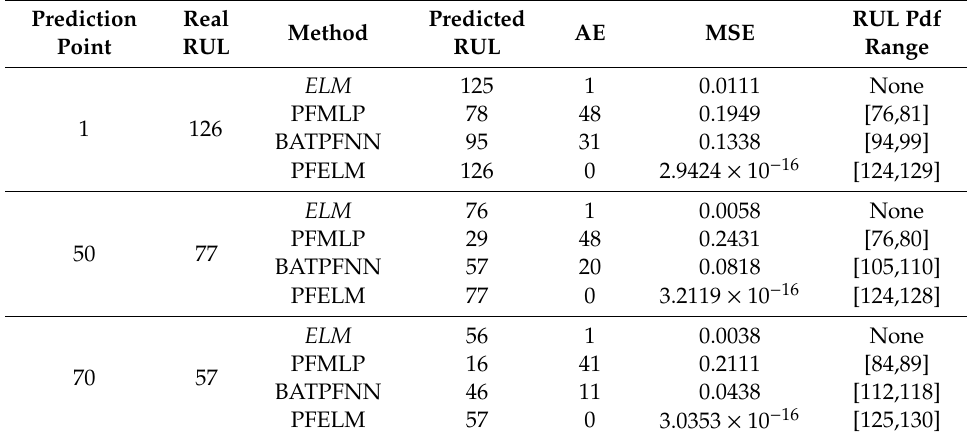
Figure 9. Capacity prediction error from the 70th cycle. Table 2. Comparison of Prognosis Results of B0005.